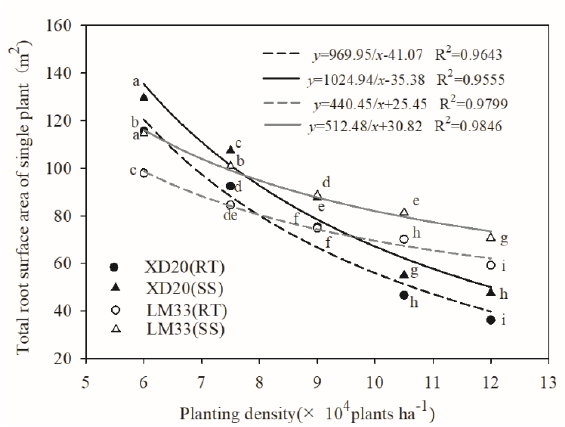
Figure 2. Root length of high-yielding spring maize under different tillage methods and planting densities. Different letters on the graph indicate significant differences at p < 0.05.